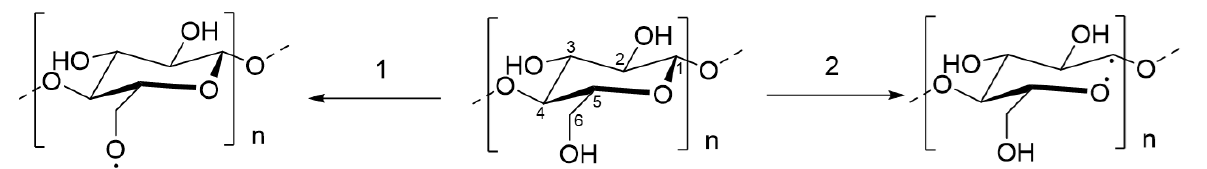
Figure 7. Radical formation on cellulose molecules upon exposure to oxygen plasma: (1) dehydro- genation at C6 and (2) cleavage of pyranosidic bond (O(ring)-C1).